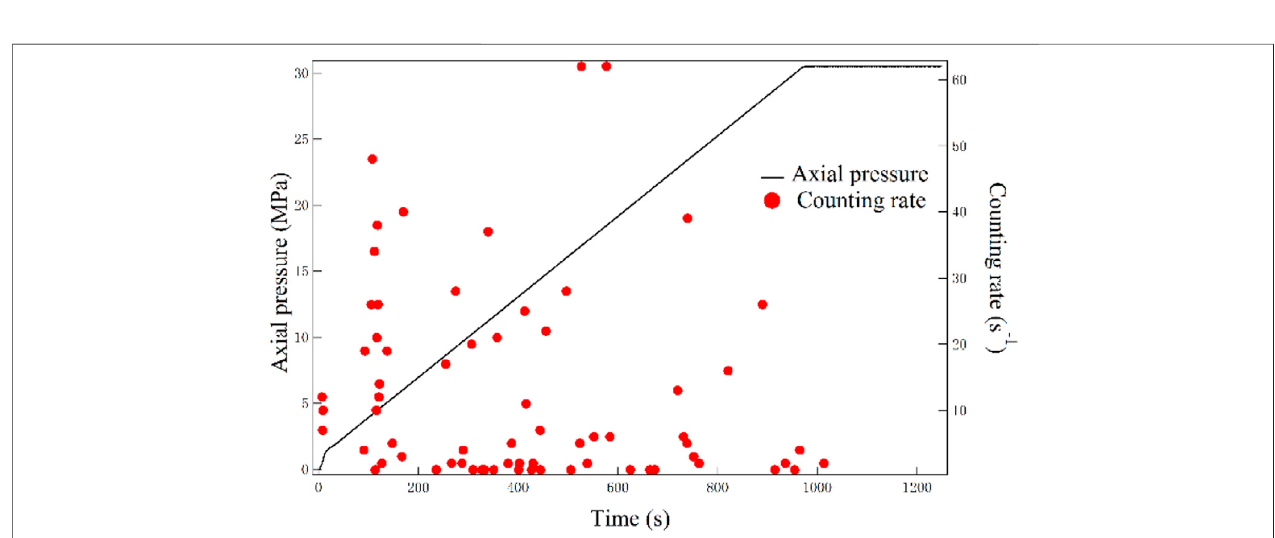
Frontiers in Earth Science |